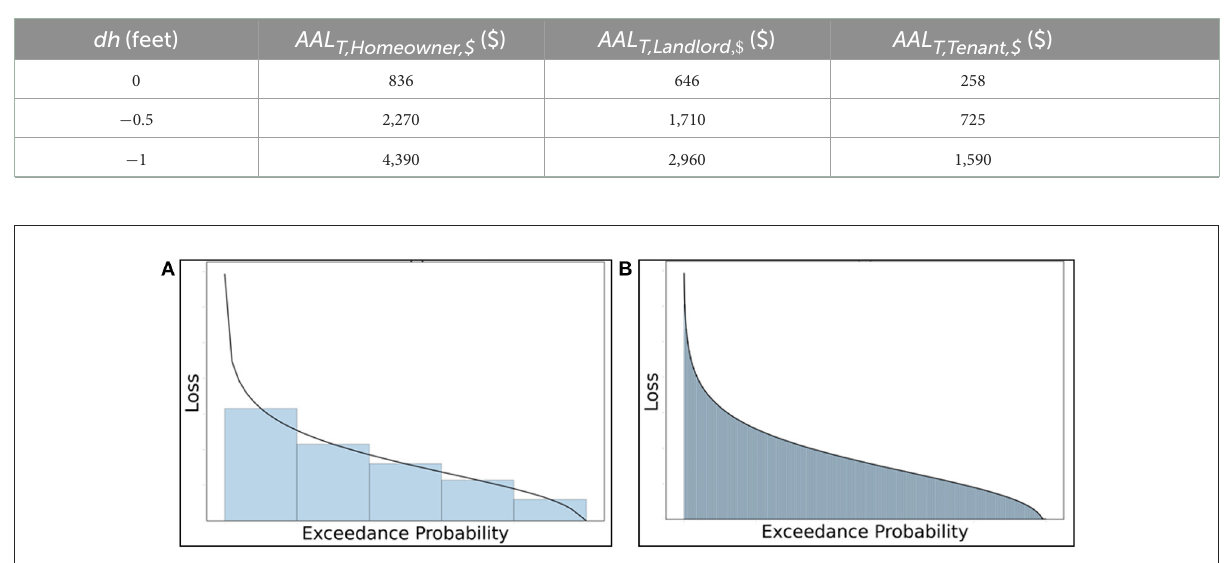
FIGURE7 Comparison of coarseness using the Riemann sum approach: (A) coarse trapezoidal areas under the loss-exceedance probability curve in the Hazus-MH approach vs. (B) fine trapezoids used in the proposed AAL